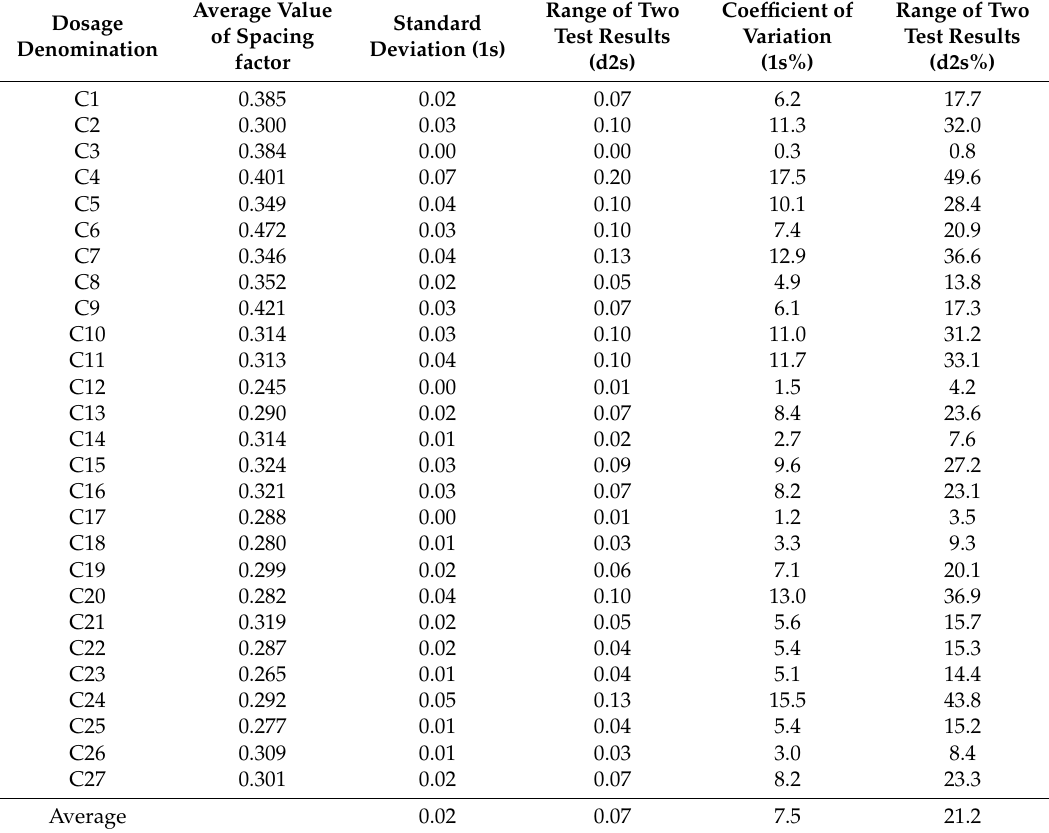
Table A1. Average value and dispersion data of the spacing factor of the 27 dosages (two slabs per